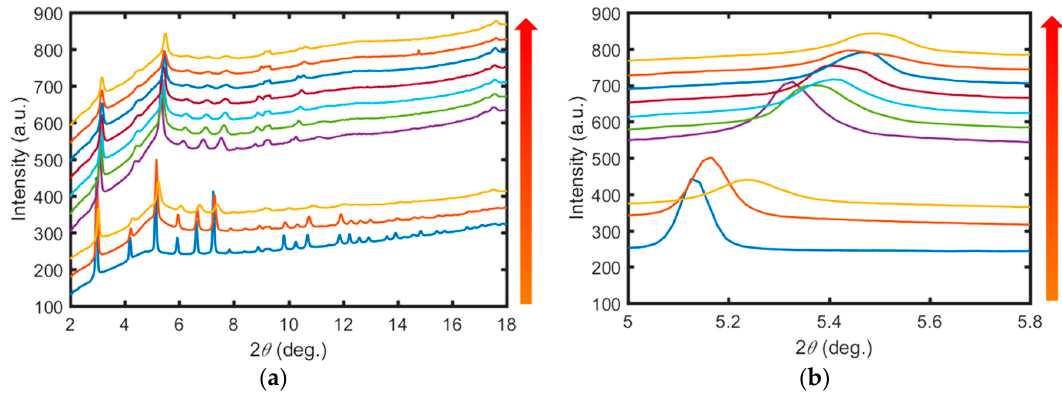
Figure 6. The representative synchrotron powder diffraction patterns of MAF-7 at 0, 0.177, 0.460, 0.862, 1.454, 1.848, 2.244, 2.829, 3.313, and 3.755 GPa, respectively. ( a ) Pressure increases from the bottom (0 GPa) to the top (3.755 GPa); and ( b ) right shift of the characteristic peak (112) with increasing pressure.